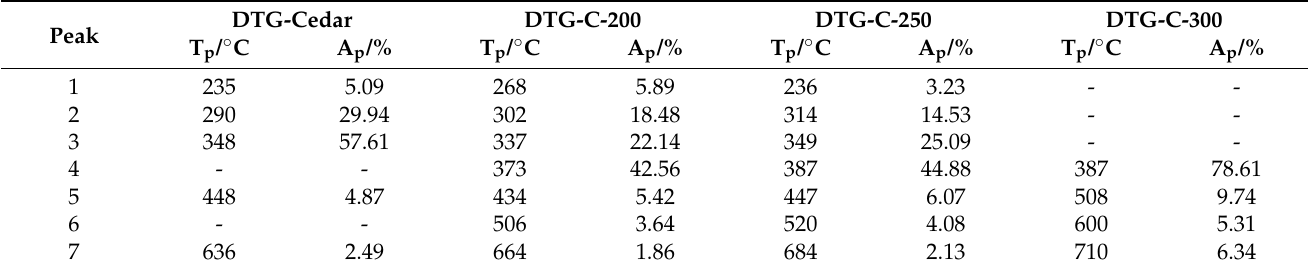
Table 4. Fitting results of DTG curves.